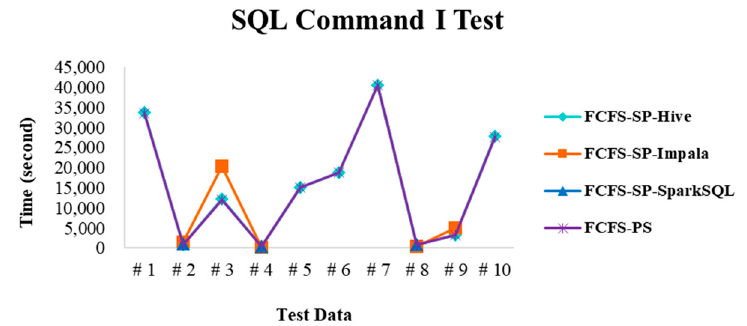
Figure 15. Execution time of SQL command I in test environment I. Appl. Sci. 2018 , 8 , x FOR PEER REVIEW